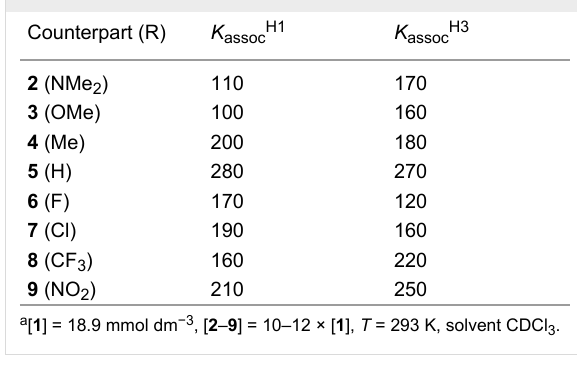
The correlation of chemical shift of H1/H7 and H3/H5 with temperature is high in the range of − 40 °C to ca. +5 °C. The chemical shifts deviate from linear function above +5 °C